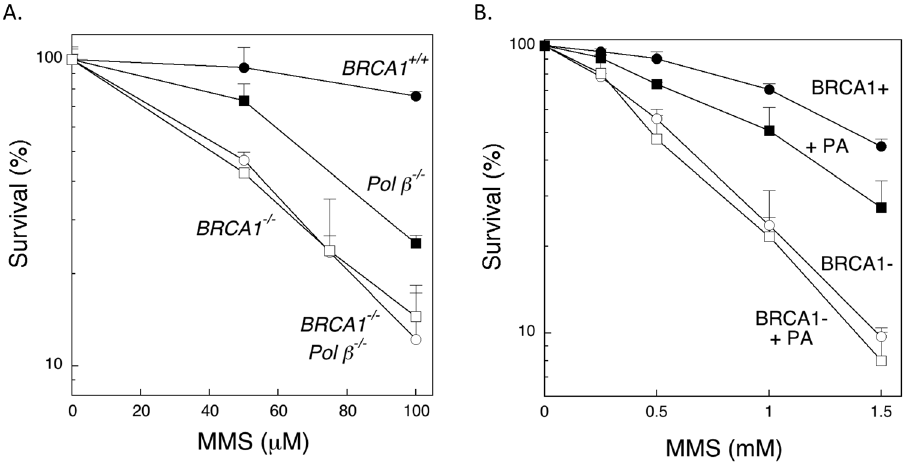
Figure 3. Analysis of DT40 and human cell survival after MMS treatment, as a function of BRCA1 and pol b expression and combined inactivation of BRCA1 and pol b . Experiments were conducted as described under ‘‘Materials and Methods’’. A. DT40 BRCA1 + / + (wild- type), BRCA1 2 / 2 , Pol b 2 / 2 and BRCA1 2 / 2 /Pol b 2 / 2 double knockout cells were treated with MMS and survival was measured by colony formation. B. Human BRCA1-expressing ( + ) and negative ( 2 ) cells were treated with MMS in the presence or absence of the pol b inhibitor PA (300 m M for 24 h). Results with error bars represent the mean 6 SEM of at least 3 independent experiments.